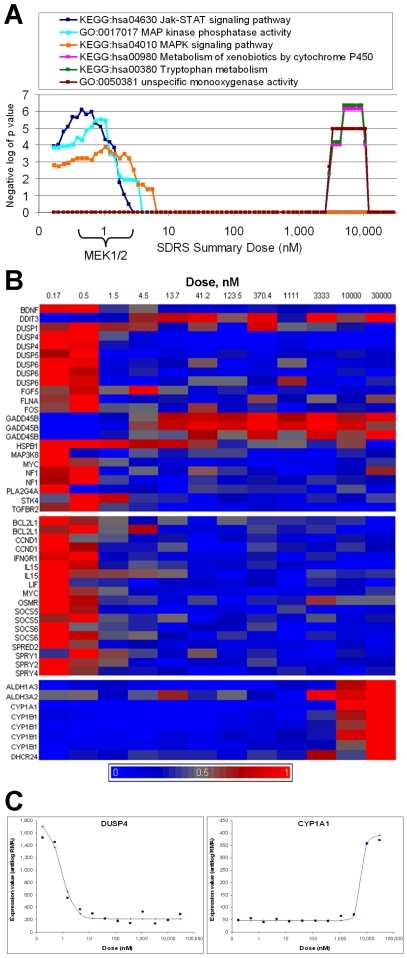
Pathway analysis applied to the transcriptional response to PD0325901 at four hours.(A) Plot of significance values obtained from Fisher's exact tests performed between the lists of gene loci corresponding to response transcripts (1 to 35% FDR), and lists of gene loci representing the six biological pathways indicated. PD0325901 causes ∼50% inhibition of cellular MEK activity in the dose region indicated [33]. (B) Signal intensity for 48 response transcripts (in rows) identified by SDRS, across twelve doses of PD0325901 (columns) at 4 hours. Top panel contains transcripts related to MAPK signaling (KEGG:hsa04010). Middle panel contains transcripts related to Jak-STAT signaling (KEGG:hsa04630). Bottom panel contains transcripts mapped to the pathways for metabolism of xenobiotics by cytochrome P450 (KEGG:hsa00980) and tryptophan metabolism (KEGG:hsa00380). For visualization, RMA signal intensity data was reverse-logged and scaled from zero (blue) to one (red) for each probeset. (C) Experimental data for probesets corresponding to DUSP4 (204014_at, EC50 0.9 nM, left panel), annotated to the pathway for MAPK signaling (KEGG:hsa04010), and CYP1A1 (205749_at, EC50 6.0 µM, right panel), annotated to the pathway for metabolism of xenobiotics by cytochrome P450 (KEGG:hsa00980), with dose response curves obtained from the optimal model parameters established by SDRS.